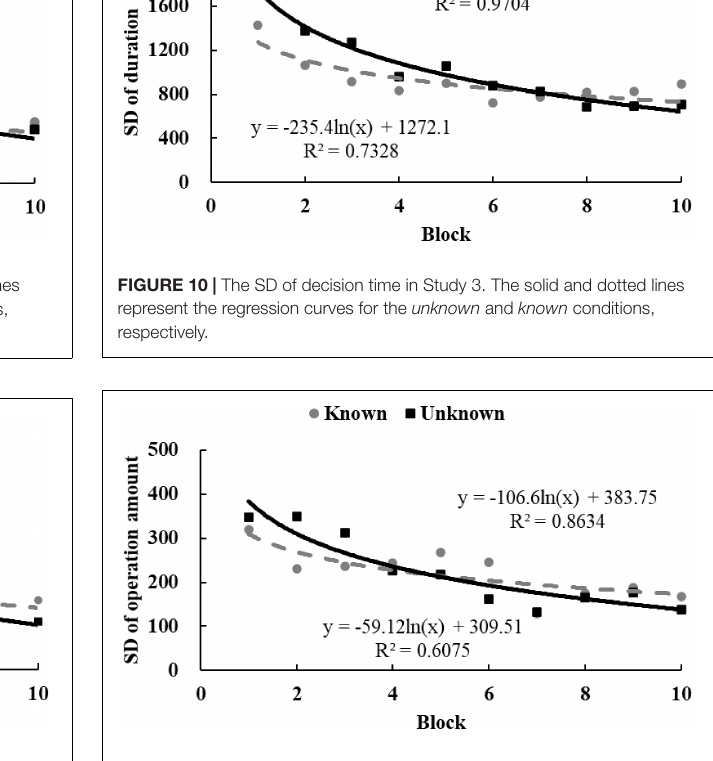
FIGURE 9 | The M of operation amount in Study 3. The solid and dotted lines represent the regression curves for the unknown and known conditions, respectively.